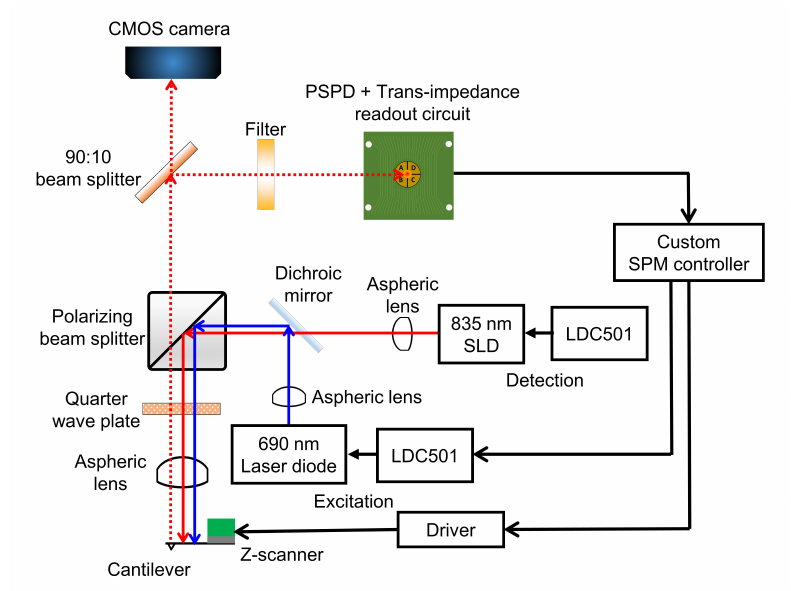
Figure 1. Schematic of the optical architecture of the proposed design. All components are contained in the scan-head except the laser diode controllers, the scanning probe microscope (SPM) controller, deflection signal readout circuit and the piezo